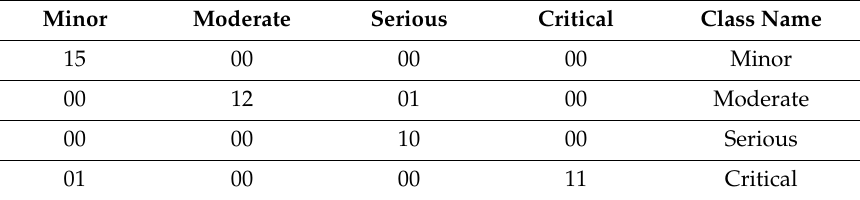
Table 8. Confusion Matrix for fold 1.